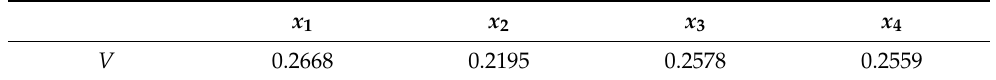
Table 7. Ranking vector of the possibility degree